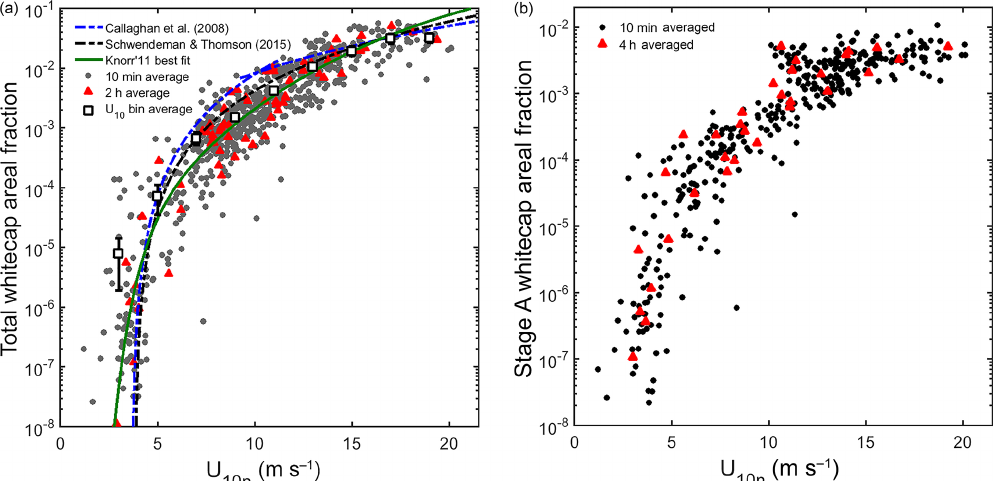
Figure 2. Semi-log plots of whitecap areal fraction as a function of mean horizontal wind speed at 10m above the sea surface ( U 10 n ) during the Knorr_11 cruise. 10min average (grey dots) and 2h average (red triangles) data are shown on both panels. (a) Total whitecap area ( W T ) versus U 10 n bin-averaged data (open squares, 2ms − 1 bins). The best fit line to Knorr_11 2h average data (green; log 10 ( W T ) = − 42 . 19 e ( − 0 . 95 U) − 6 . 5 e ( − 0 . 0886 U) ) and wind speed parameterisations from the recent literature are shown for reference. (b) Whitecap area considered to be solely from wave breaking (Stage A whitecaps ( W A ) ; see text for definition).